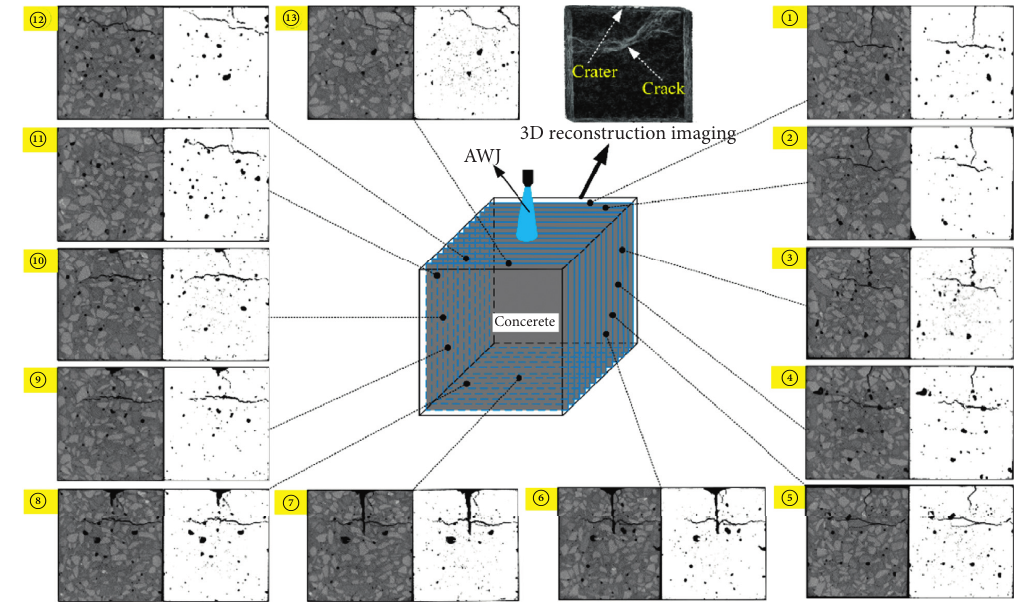
Figure 4: Distribution of the CT slices and scanning results.